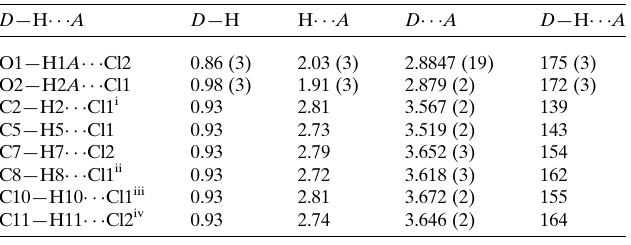
Table 1 Hydrogen-bond geometry (A˚ , (cid:4) ).